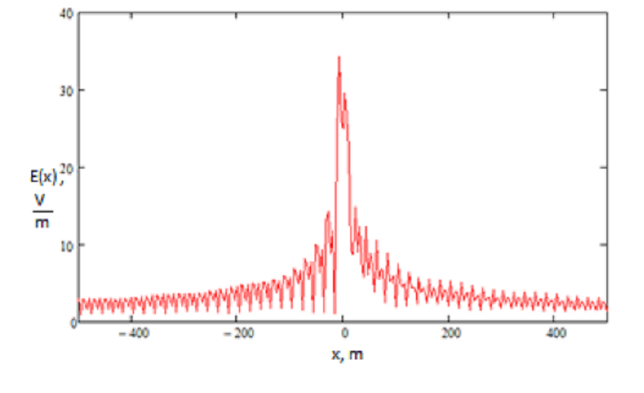
Fig. 4. Amplitude distribution of point source field for the frequency of 28.5 MHz The calculation time on a medium-powered computer is not more than 2 minutes.